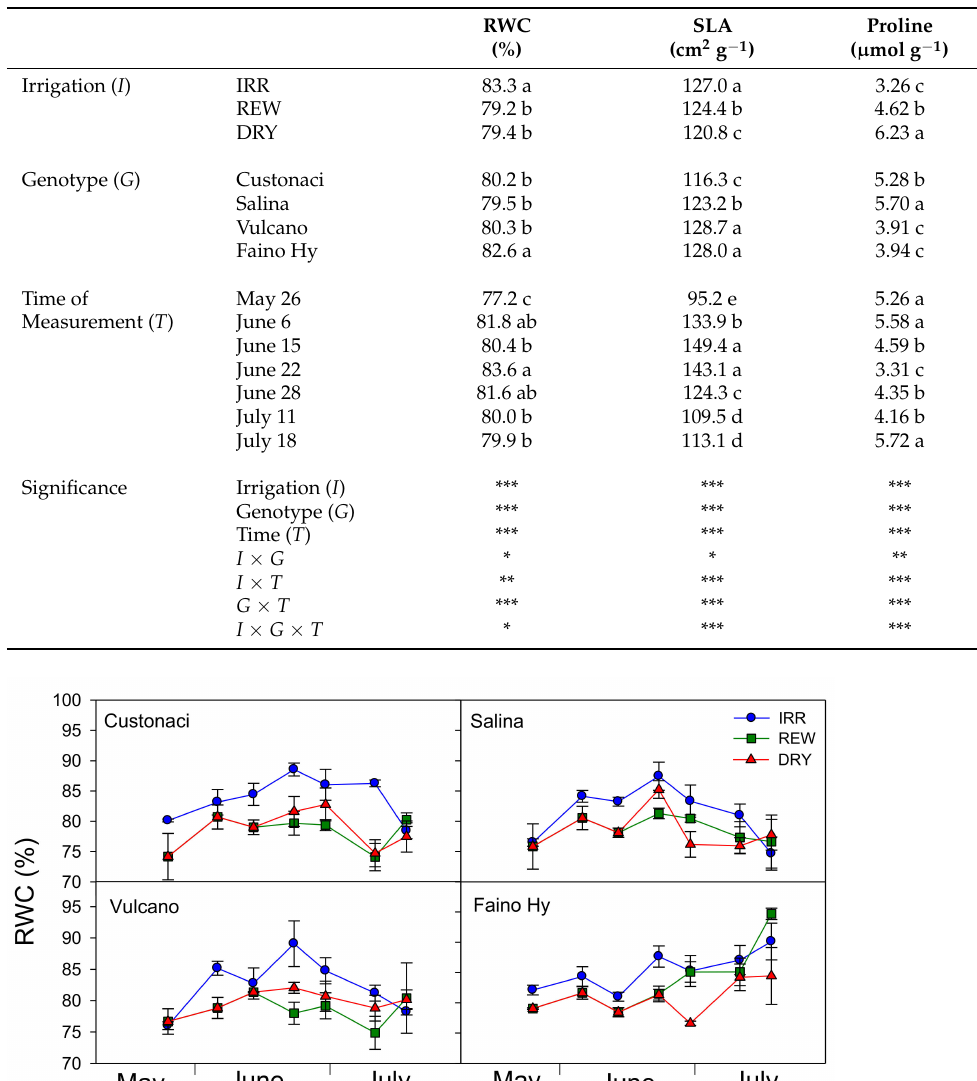
Table 1. Mean effects of irrigation ( I ) (IRR: full irrigation; REW: rewatering; DRY: no irrigation), genotype ( G ), and time of measurement ( T ) on RWC, SLA, and proline content in tomato. Values within each column, followed by the same letter, do not significantly differ at p ≤ 0.05 (Tukey’s test). ANOVA significance results are also reported: significant at p ≤ 0.05 (*), 0.01 (**), and 0.001 (***).